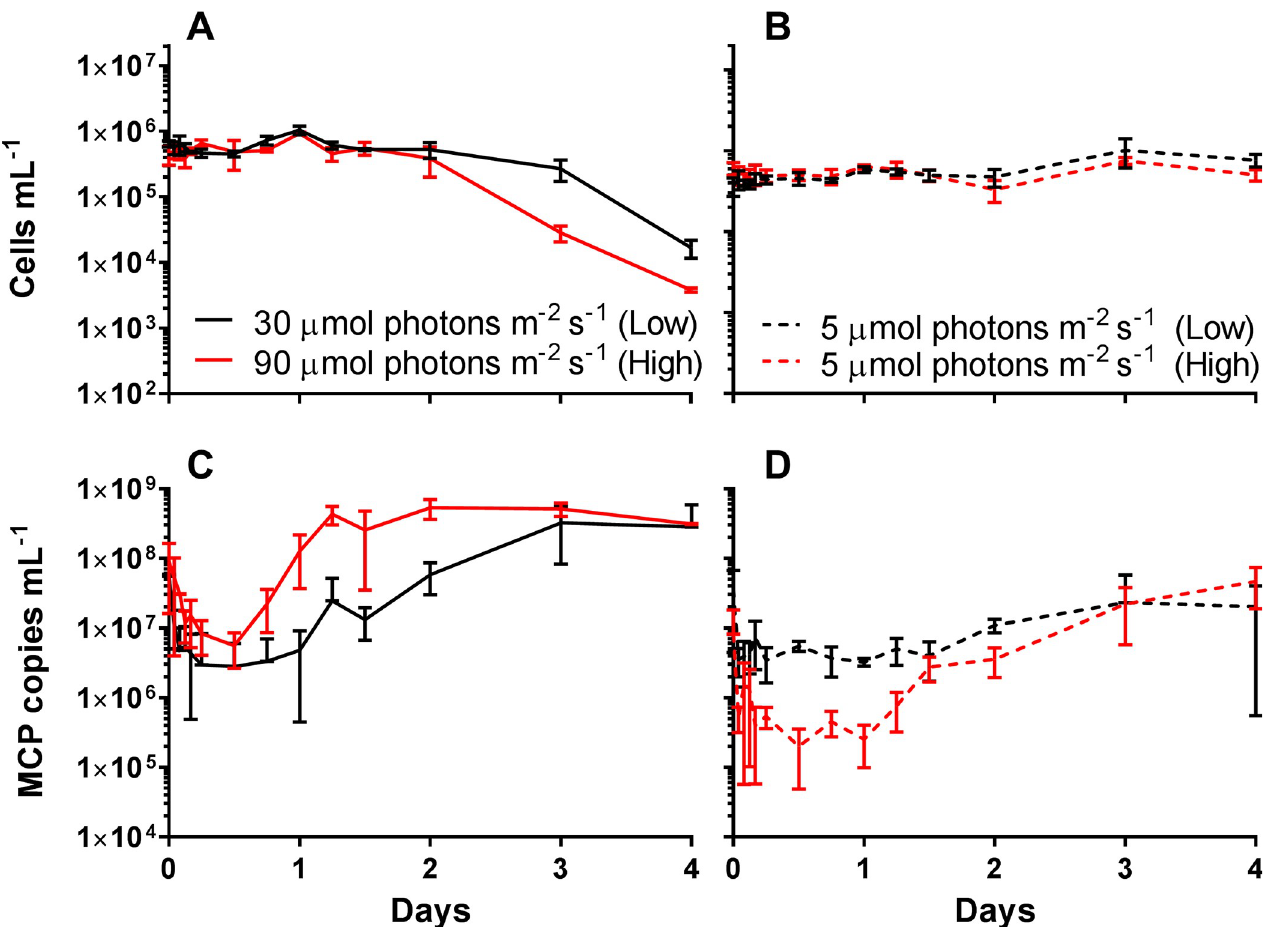
Fig 5. Aureococcus anophagefferens virus infection cycle dynamics with pre-acclimation to 5 μ mol photons m -2 s -1 for one day before infection. Red lines are high irradiance acclimated (90 μ mol photons m -2 s -1 ) and black lines are low irradiance acclimated (30 μ mol photons m -2 s -1 ). A . anophagefferens host concentrations for acclimated cultures A) maintained at acclimated irradiance levels after infection or B) infected after one day at 5 μ mol photons m -2 s -1 . MCP copies mL -1 for acclimated cultures C) maintained at acclimated irradiance levels after infection or D) infected after one day at 5 μ mol photons m -2 s -1 . Day 0 on the graphs are when cultures were infected. Points are for n = 3 three biological replicates ±